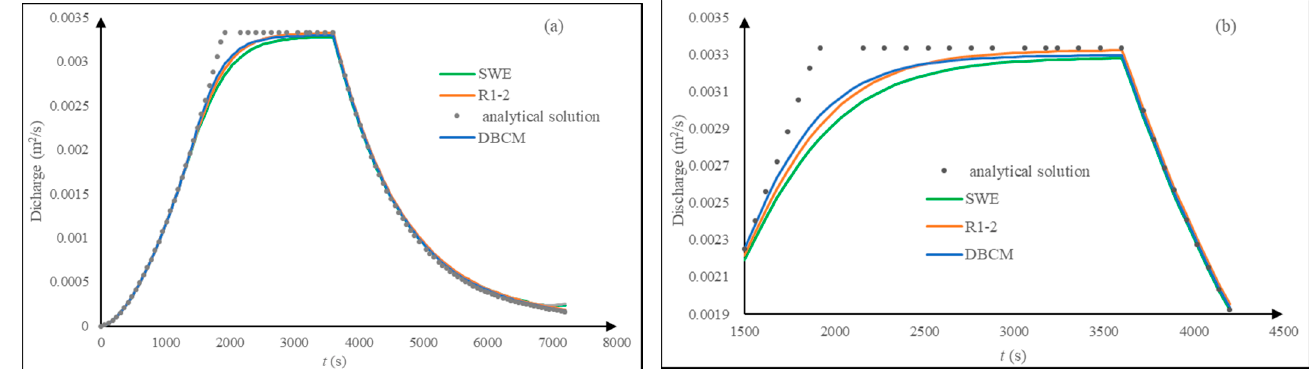
Figure 5. Discharge hydrographs obtained from different models of the case study: ( a ) whole discharge hydrograph; ( b ) peak discharge.